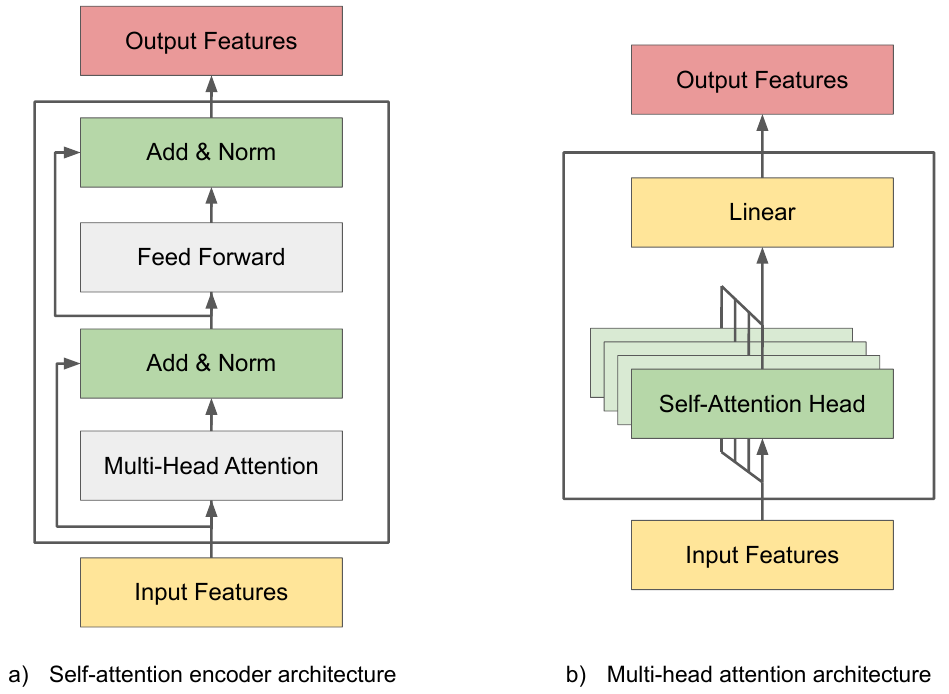
Figure 6. Self-attention architecture and multi-head attention